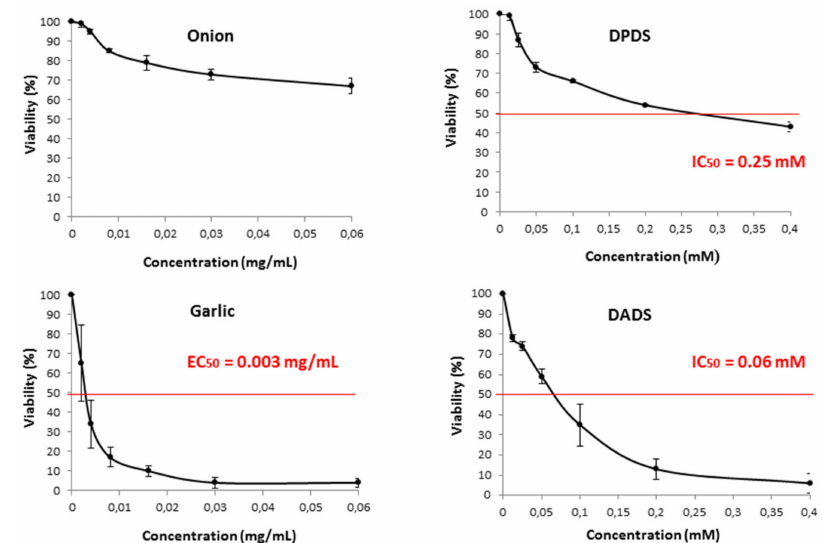
Figure 3. Viability of HL60 cells treated during 72 h with di ff erent concentrations of onion, garlic, and their respective organosulfur compound, DPDS, and DADS. Curves are plotted as mean percentages with respect to the control (three independent replicates). IC 50 : Inhibition concentration 50 for the tested organosulfur. EC 50 : e ff ective concentration 50 for the tested extracts. The results of proapoptotic e ff ects of di ff erent concentrations of garlic, onion, DADS, and DPDS in HL60 cells measured as internucleosomic programmed fragmentation [66] are shown in Figure 4. DNA fragmentation was observed at high concentrations of garlic (0.03 and 0.06 mg / mL) and DADS onions nor by DPDS at the assayed concentrations.